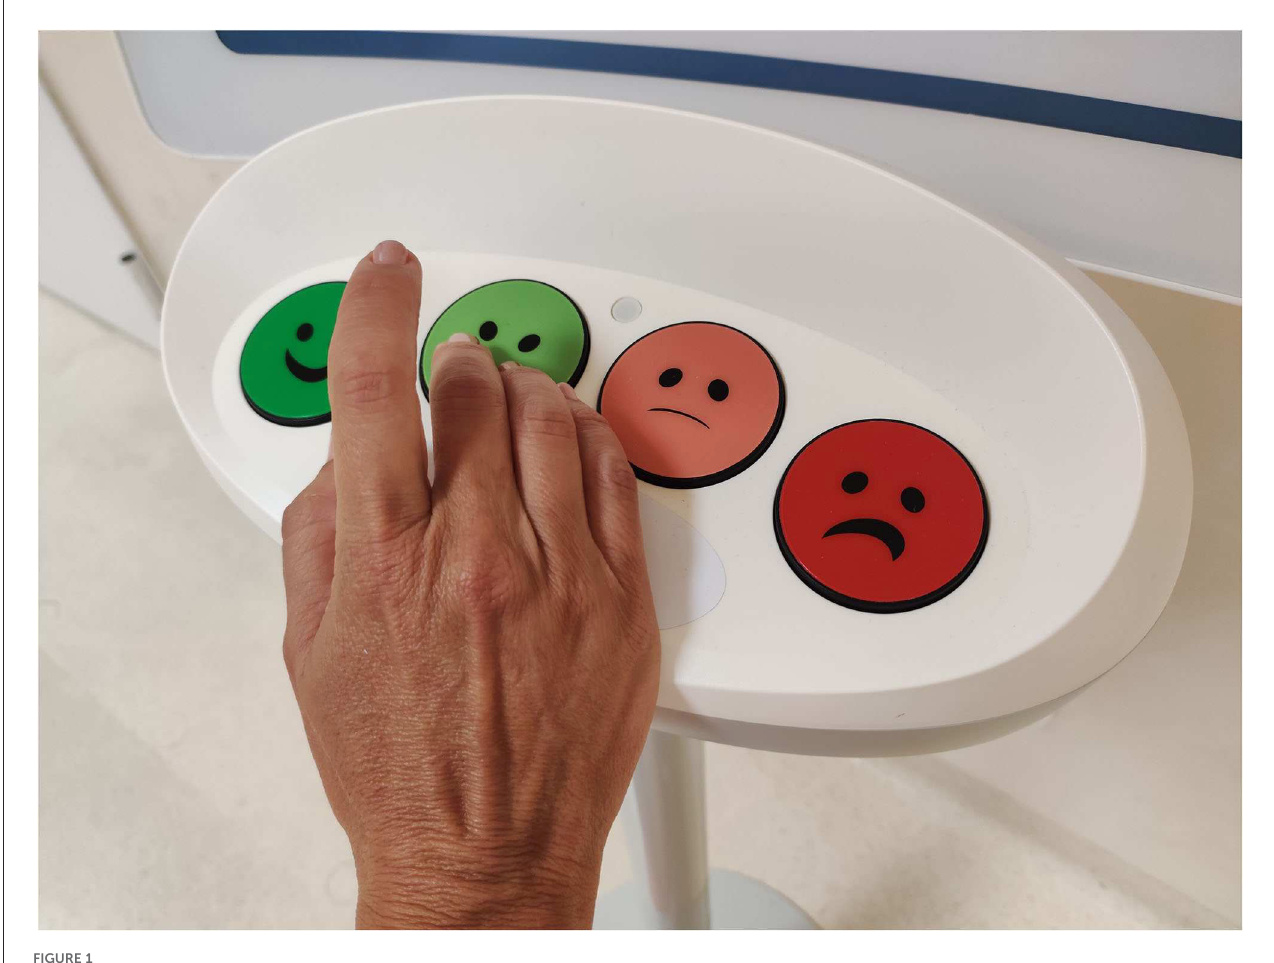
FIGURE1 RAMSI project